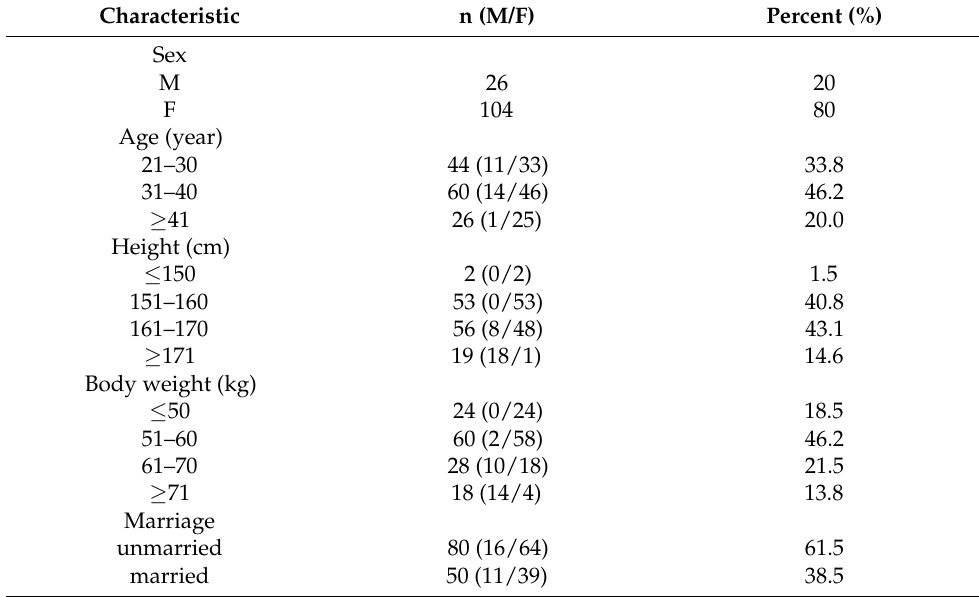
Table 2. Demographic characteristics of school counselors (n =